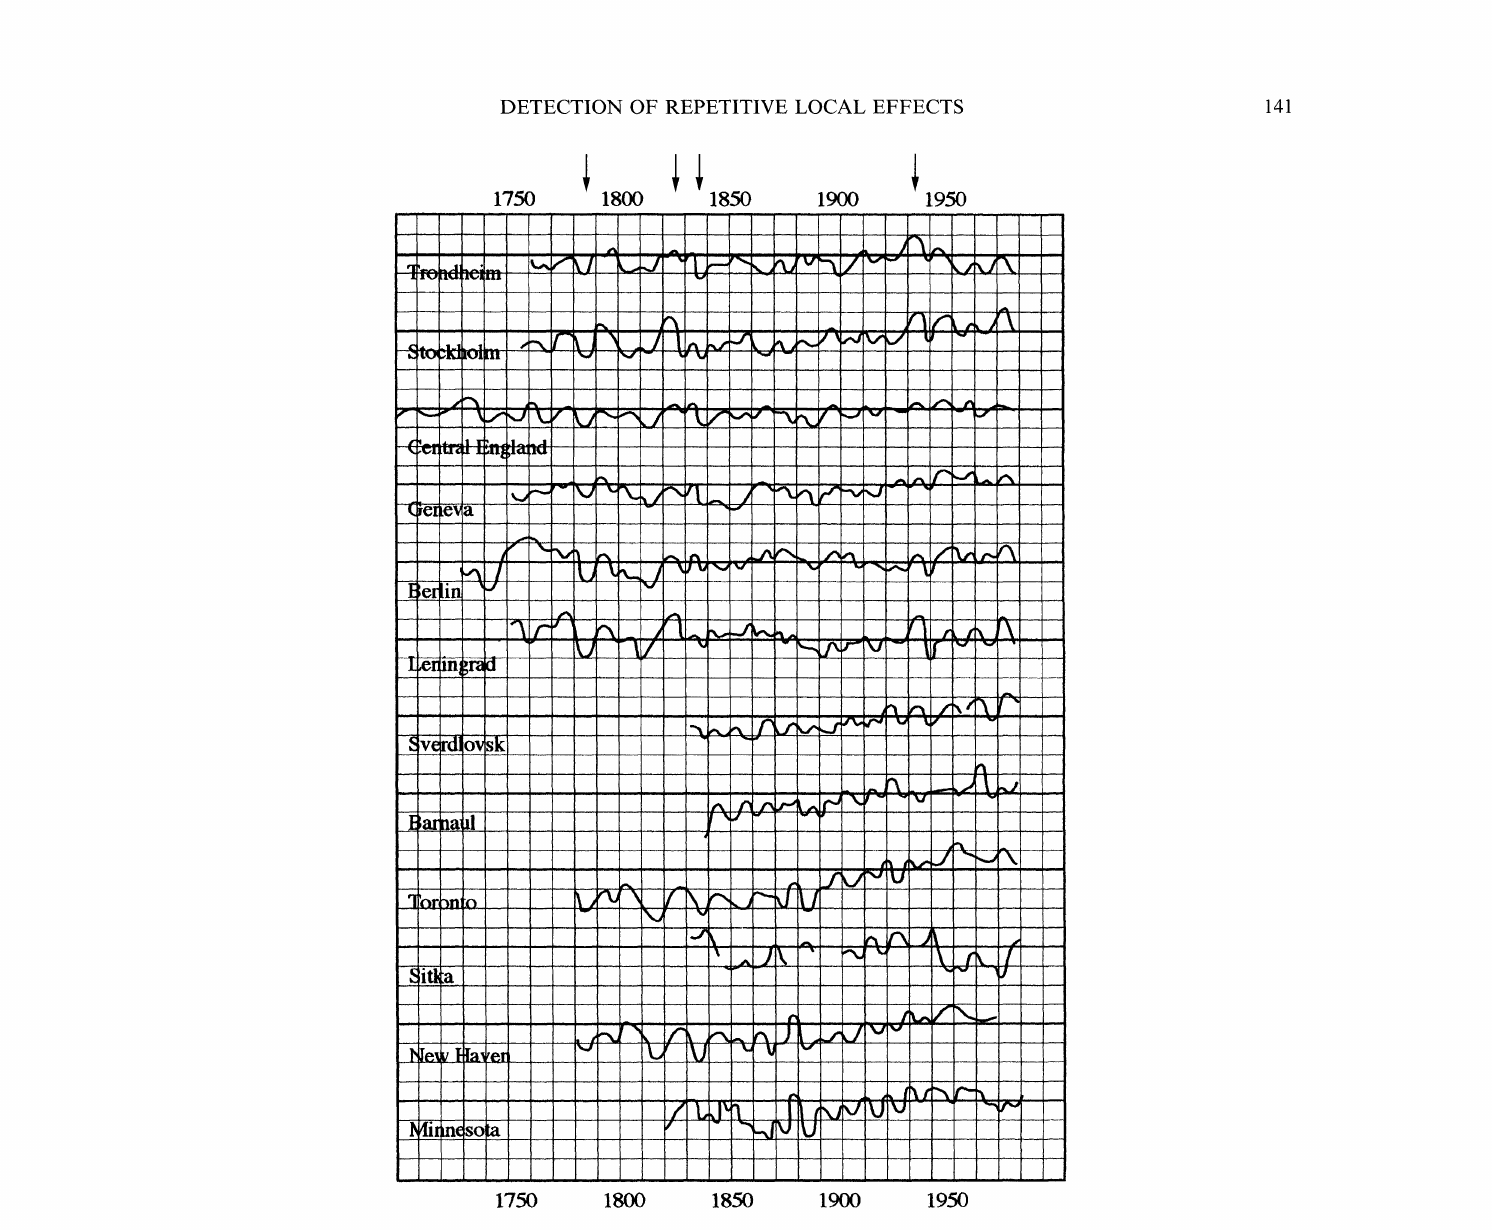
FIGURE 2 Temperature fluctuations (cf. Bradley,